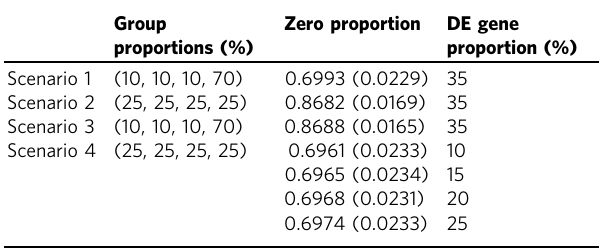
(Fig. 3e, f). In addition, plasmacytoid dendritic cells (in gray)